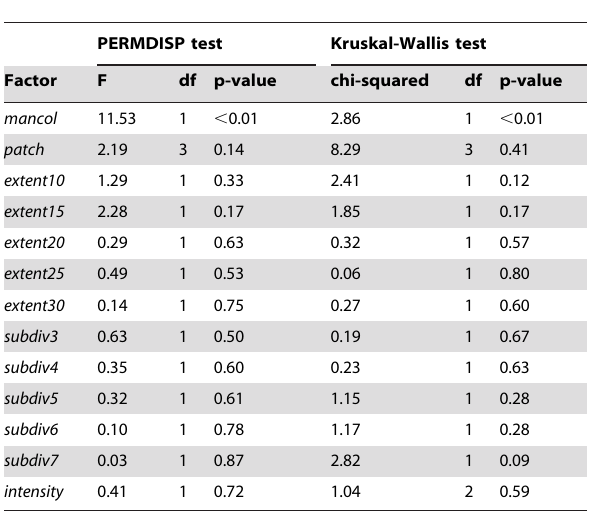
Table 3. PERMDISP tests of homogeneity of dispersions (taxonomic similarity) results based on mean distance to group centroid for all groups within each factor, using log(x + 1) transformed species density data.